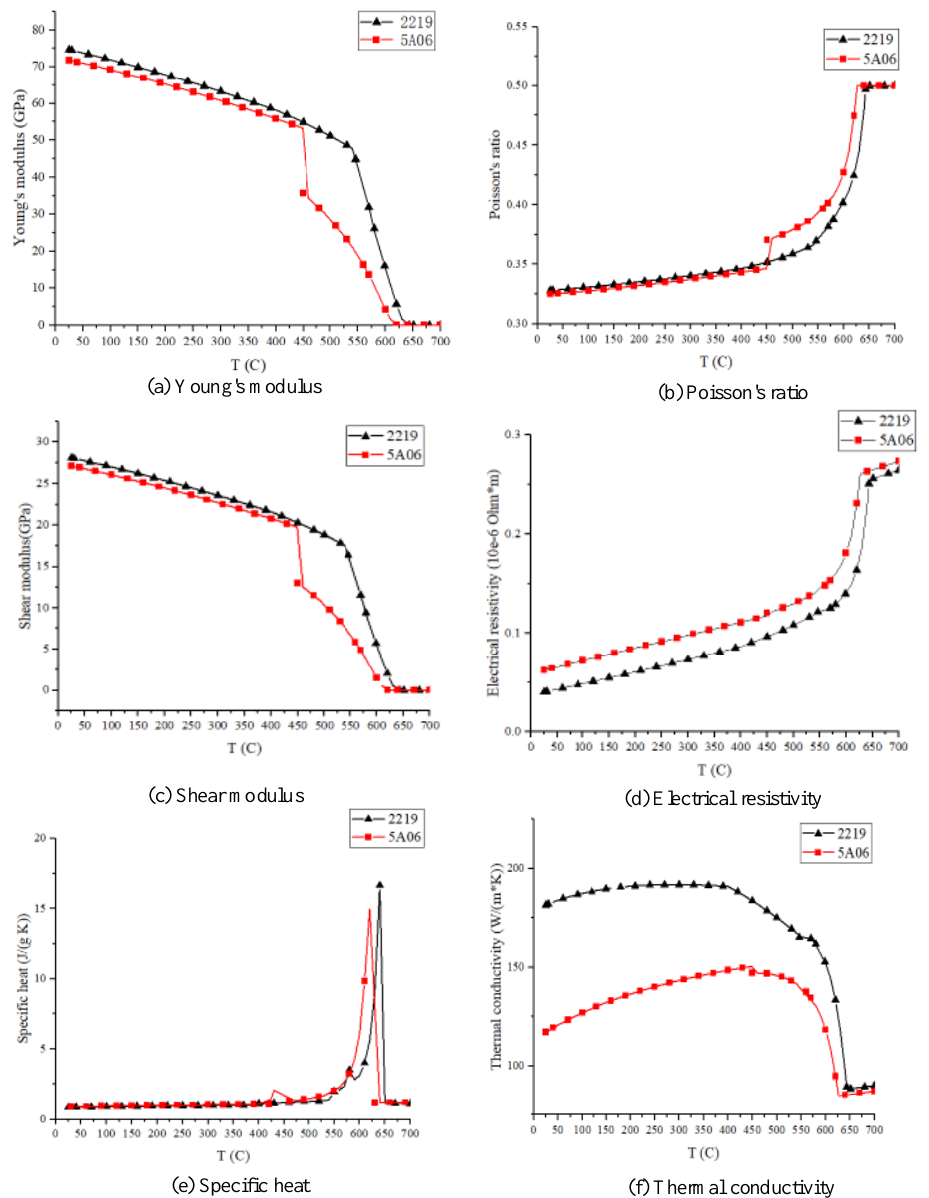
Figure 5. Mechanical properties ( a – f ), electrical conductivity ( d ), thermal properties ( e , f ) of 2219 and 5A06.